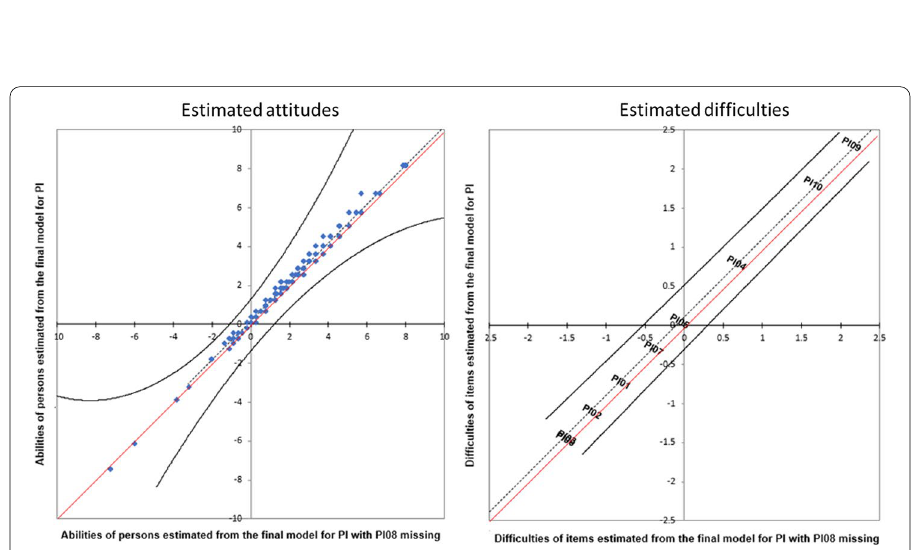
Fig. 5 Persons’ attitudes: 95% confidence interval around identity line, estimated from different sets of items from the final model